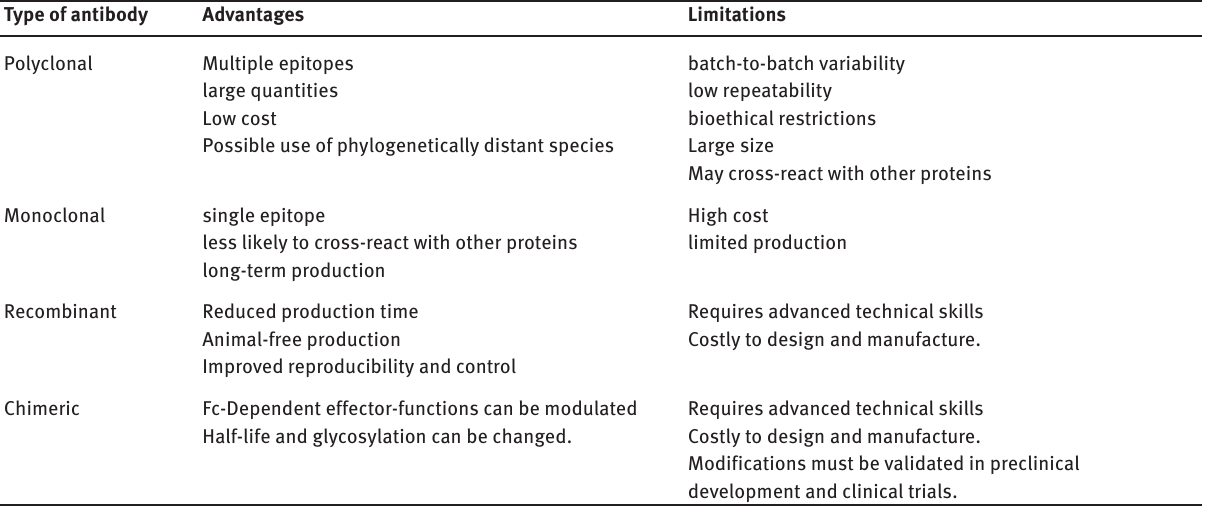
Table 3: Advantages and limitations of different types of antibodies used as enzyme inhibitors. Type of